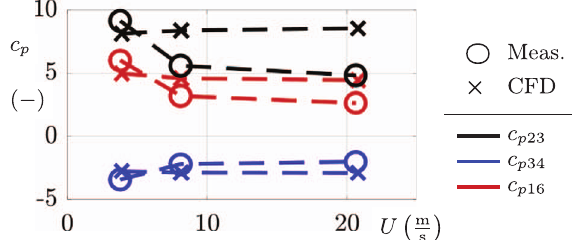
q U 2 (cid:6) (cid:7) over the 2